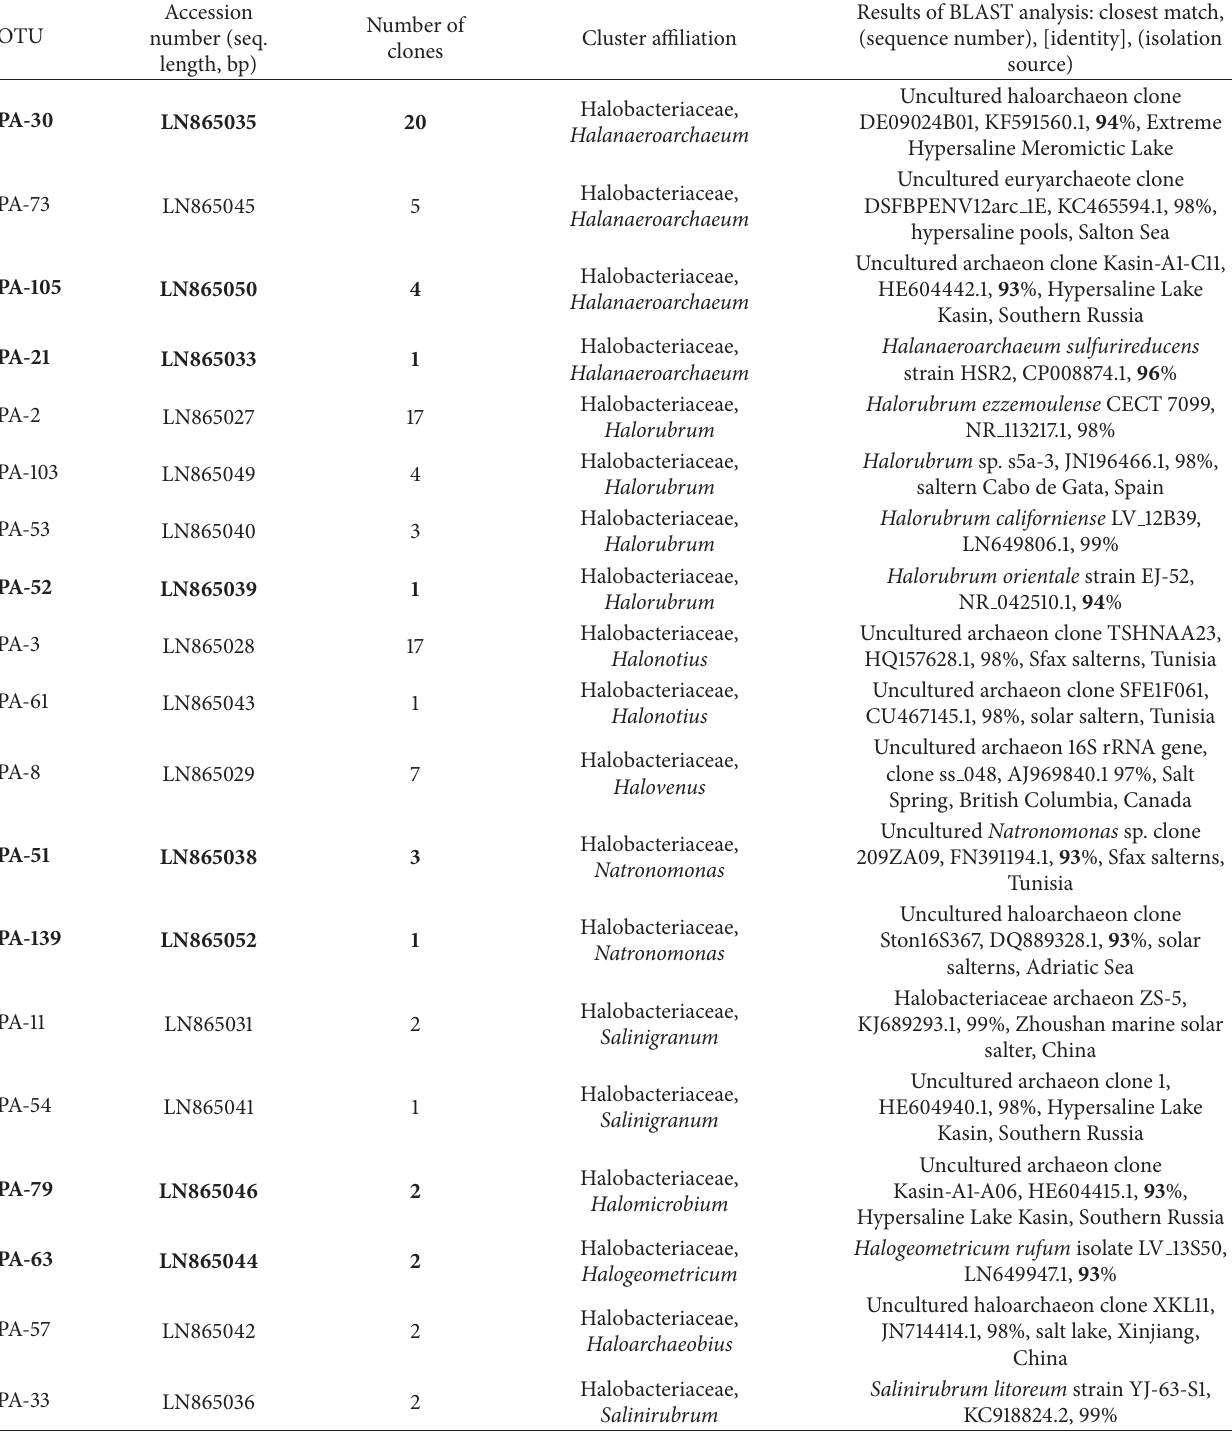
Table 1: Frequencies of OTUs within the Archaea domain derived from the 16S rRNA sequences from 1 crystallizer pond from Pomorie saltern, Bulgaria. Novel sequences (more than 3% phylogenetic distance), their relative abundance, their closest phylogenetic neighbors, and similarity among them are underlined.